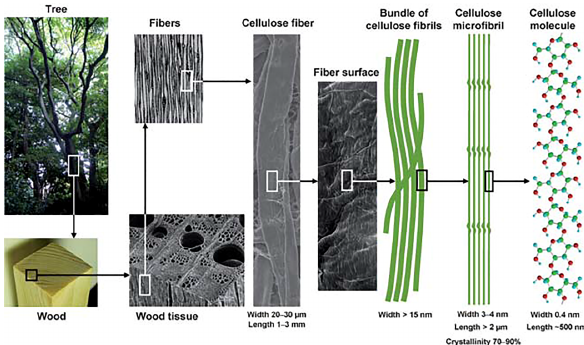
Figure 1: Structure of wood biomass and cellulose characteris- tics. Reproduced from [119] with permission of the Royal Society of